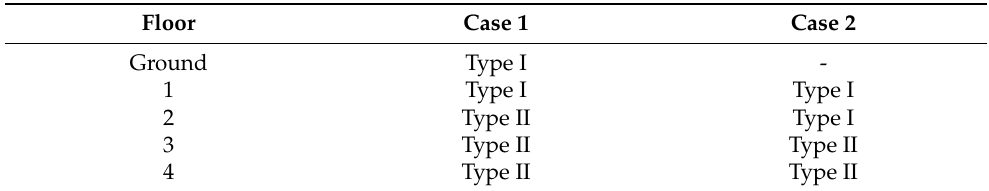
Table 1. Shear wall distribution in Cases 1 and